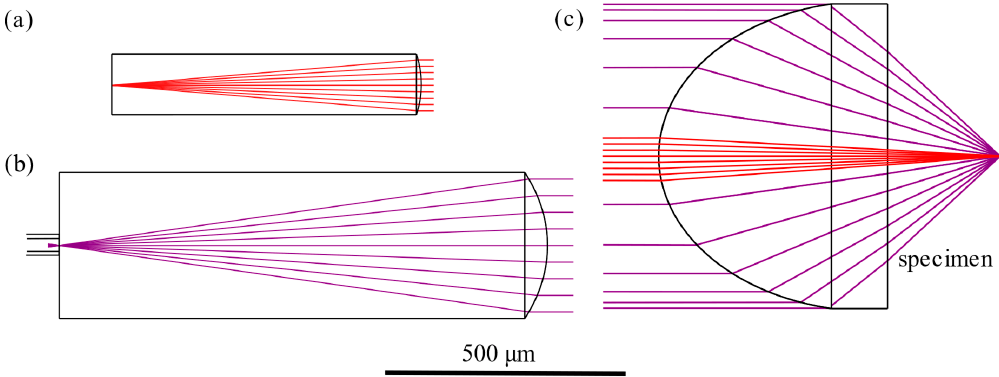
Figure 2. Ray diagrams for each of the three lens surfaces in the DOS: ( a ) L1 C , ( b ) L1 O , ( c ) L2. Each lens takes the form of a prolate asphere, which efficiently collimates or focuses the rays over the desired spectral range.